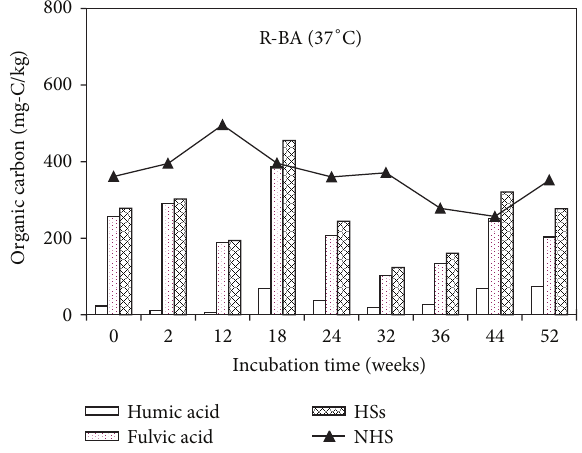
Figure 3: Humic substances and nonhumic substances contents as a function of incubation time in R-BA incubated under 37 ∘ C.